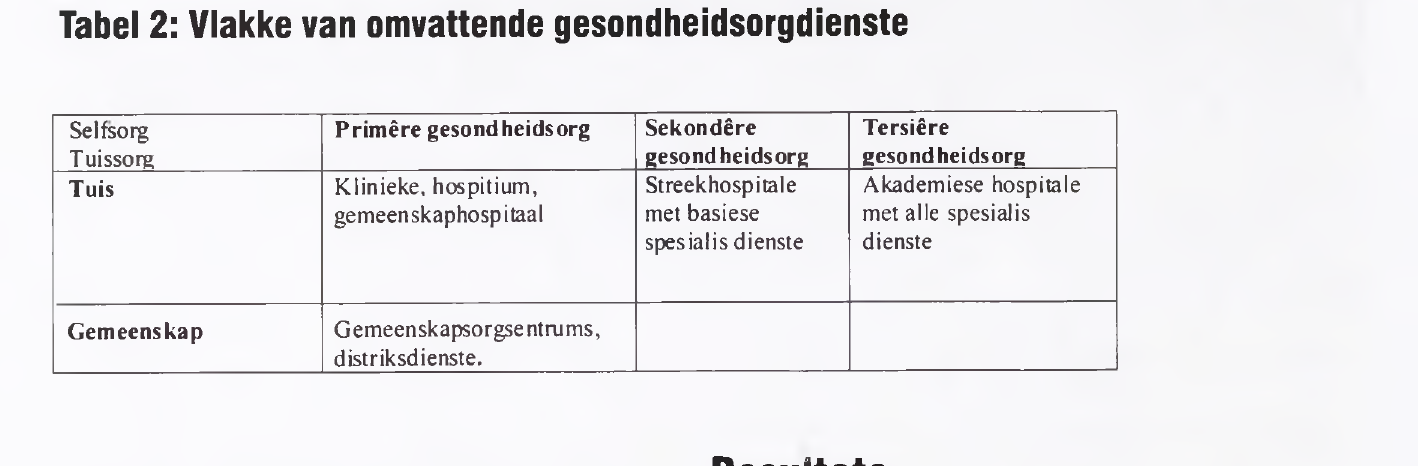
Tabel 2: Vlakke van omvattende gesondheidsorgdienste Selfsorg